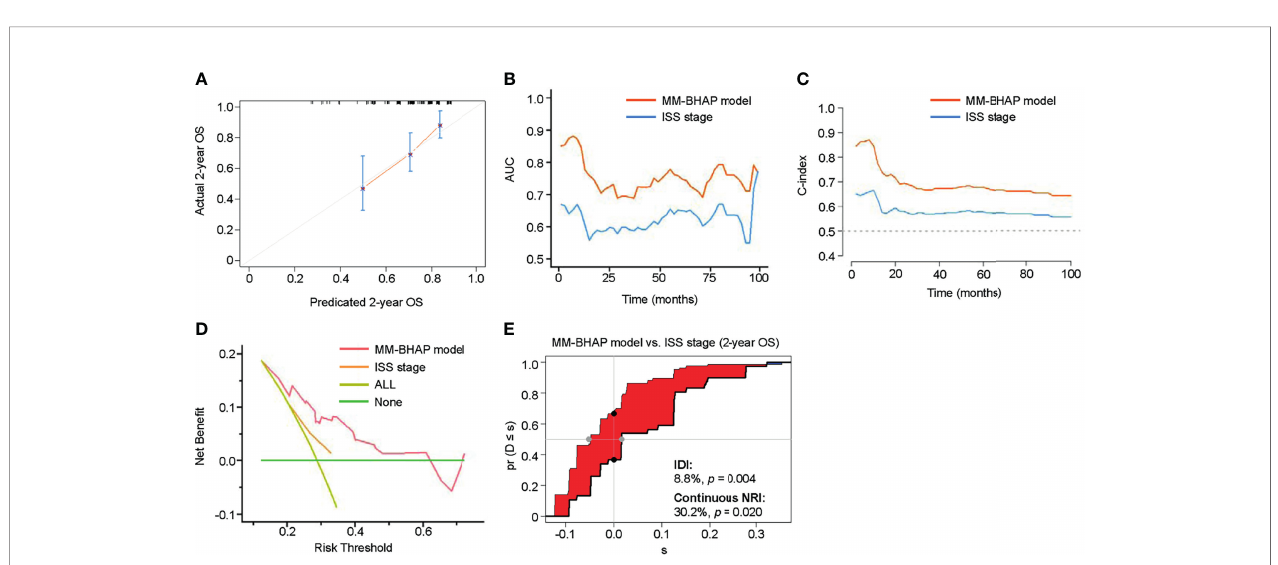
FIGURE 6 | The performance of the MM-BHAP model and ISS stage for predicting OS in the validation cohort. (A) The calibration curve of the MM-BHAP model for predicting 2-year OS. (B) The time-dependent AUC of the ROC in the two models. (C) The time-dependent Harrell ’ s C-index in the two models. (D) The DCA for predicting 2-year OS. (E) The IDI and continuous NRI of the MM-BHAP model compared to the ISS stage.